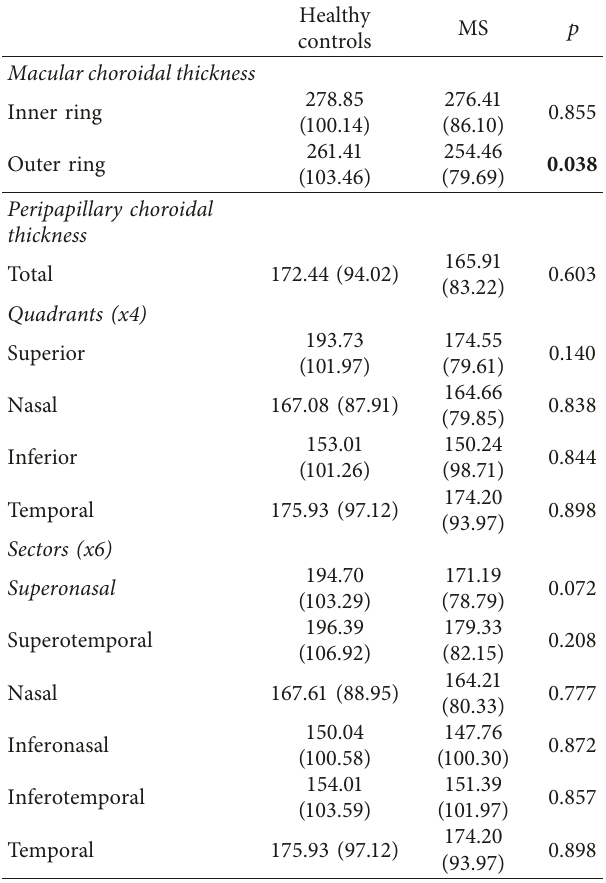
Table 3: Macular and peripapillary choroidal thickness as mea- sured with swept-source deep range imaging optical coherence tomography Triton in patients with multiple sclerosis and healthy